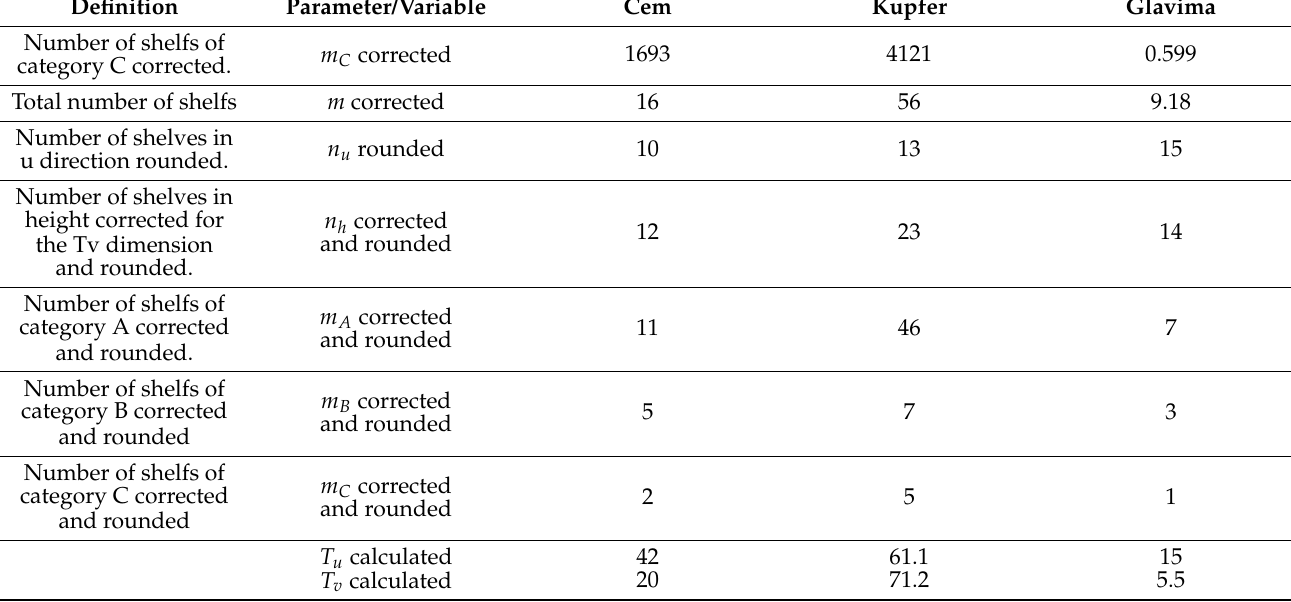
Table 10. Calculation with restricted area.(continuation of Table